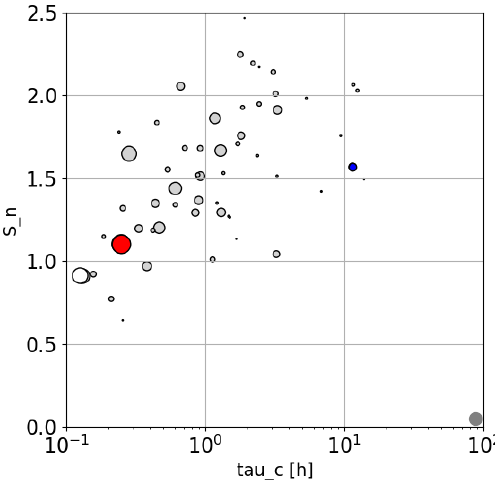
Figure 3. Scatterplot of domain-averaged, daily maximum convec- tive adjustment timescale and daily mean normalized standard devi- ation of precipitation for the entire SOP1. The prominent cases dis- cussed in Sect. 4 are highlighted: the red circle represents HyMeX IOP16a, the blue circle HyMeX 11 September 2012 and the white circle the NAWDEX case. The size of the symbols indicates the daily precipitation accumulation, with the grey circle in the bottom right corner displaying a daily domain-integrated rainfall accumu- lation of 10mm for